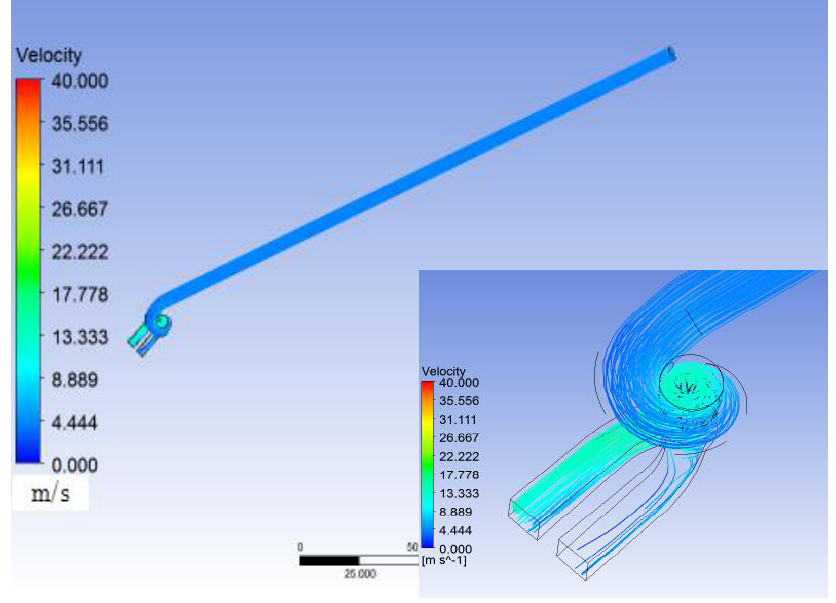
Figure 10. Velocity flow lines in Temenggor turbine unit.